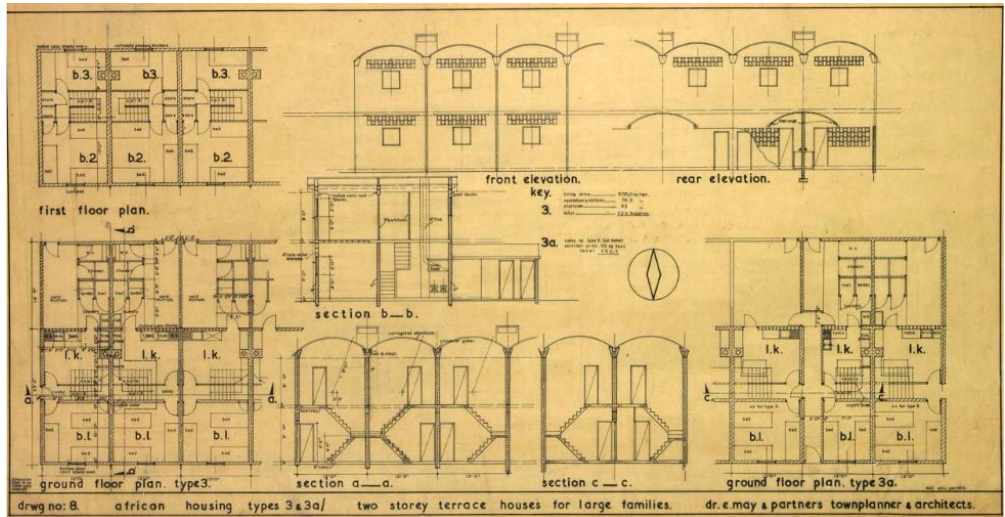
Figure 20. African Family Flats, terraced houses for large families, Satellite Port Tudor. Source: Herrel